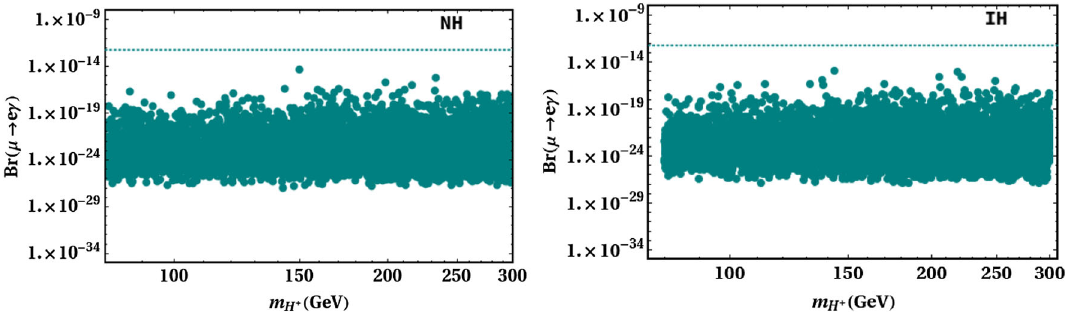
Fig. 1 Br (μ → e γ) as a function of m H + for NH and IH. The dashed horizontal lines are the recent upper